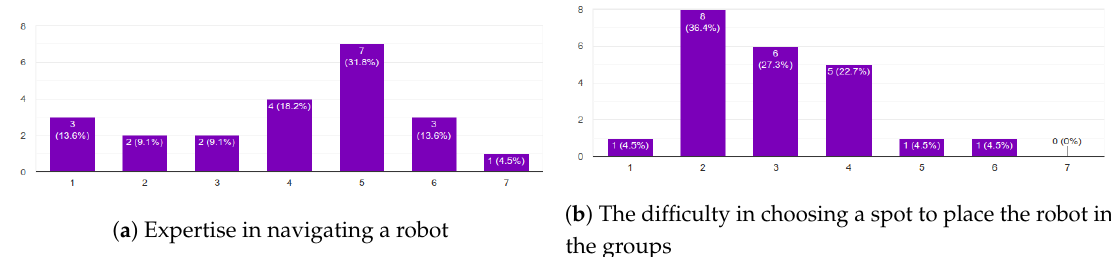
Figure 9. Subjects answered on a Likert scale of 1 to 7. 1 = easy or low and 7 = difficult or